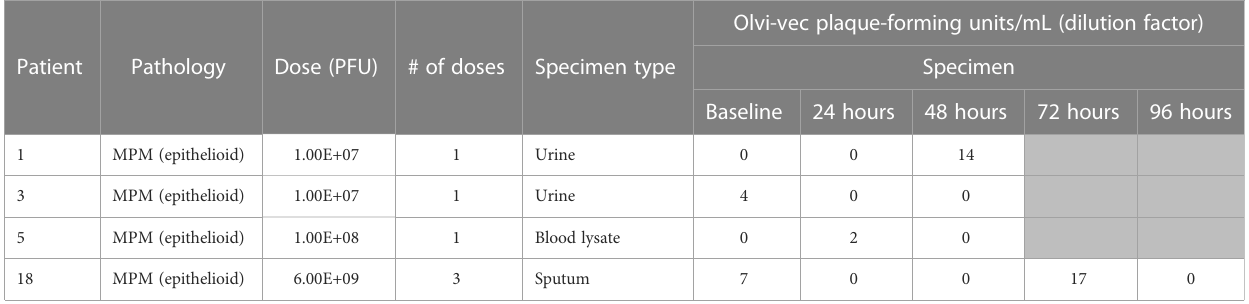
TABLE 4B Results of viral plaque assay (other